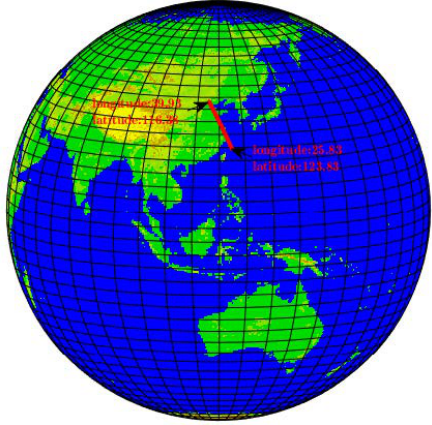
Figure 2. Ideal great circle trajectory.